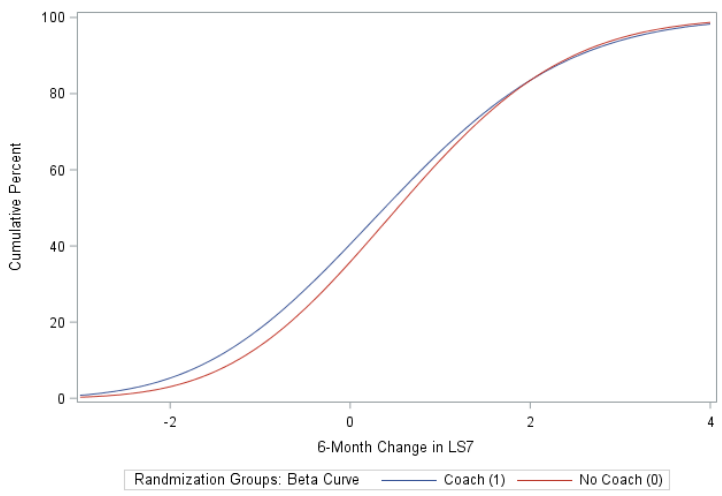
Figure 8. Cumulative distribution function of 6 − month change in LS7 Fitted with a beta function.